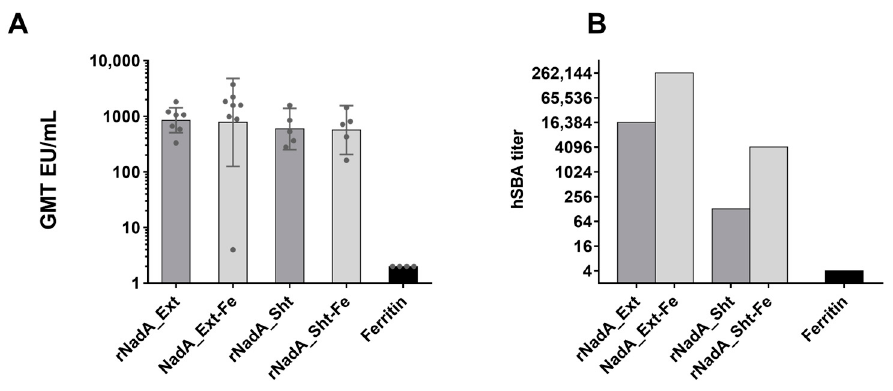
Figure 4. Immune responses elicited by NadA-ferritin nanoparticles. ( A ) Geometric mean titers of IgG induced by different constructs as detected by ELISA. ( B ) Increased serum bactericidal activity in the presence of human complement (hSBA) elicited by both nanoparticles (NadA_Ext-Fe and NadA_Sht-Fe) compared to soluble NadA. hSBA is expressed as the reciprocal of highest dilution of pooled-mice immune sera able to induce killing of 50% of meningococci in vitro.